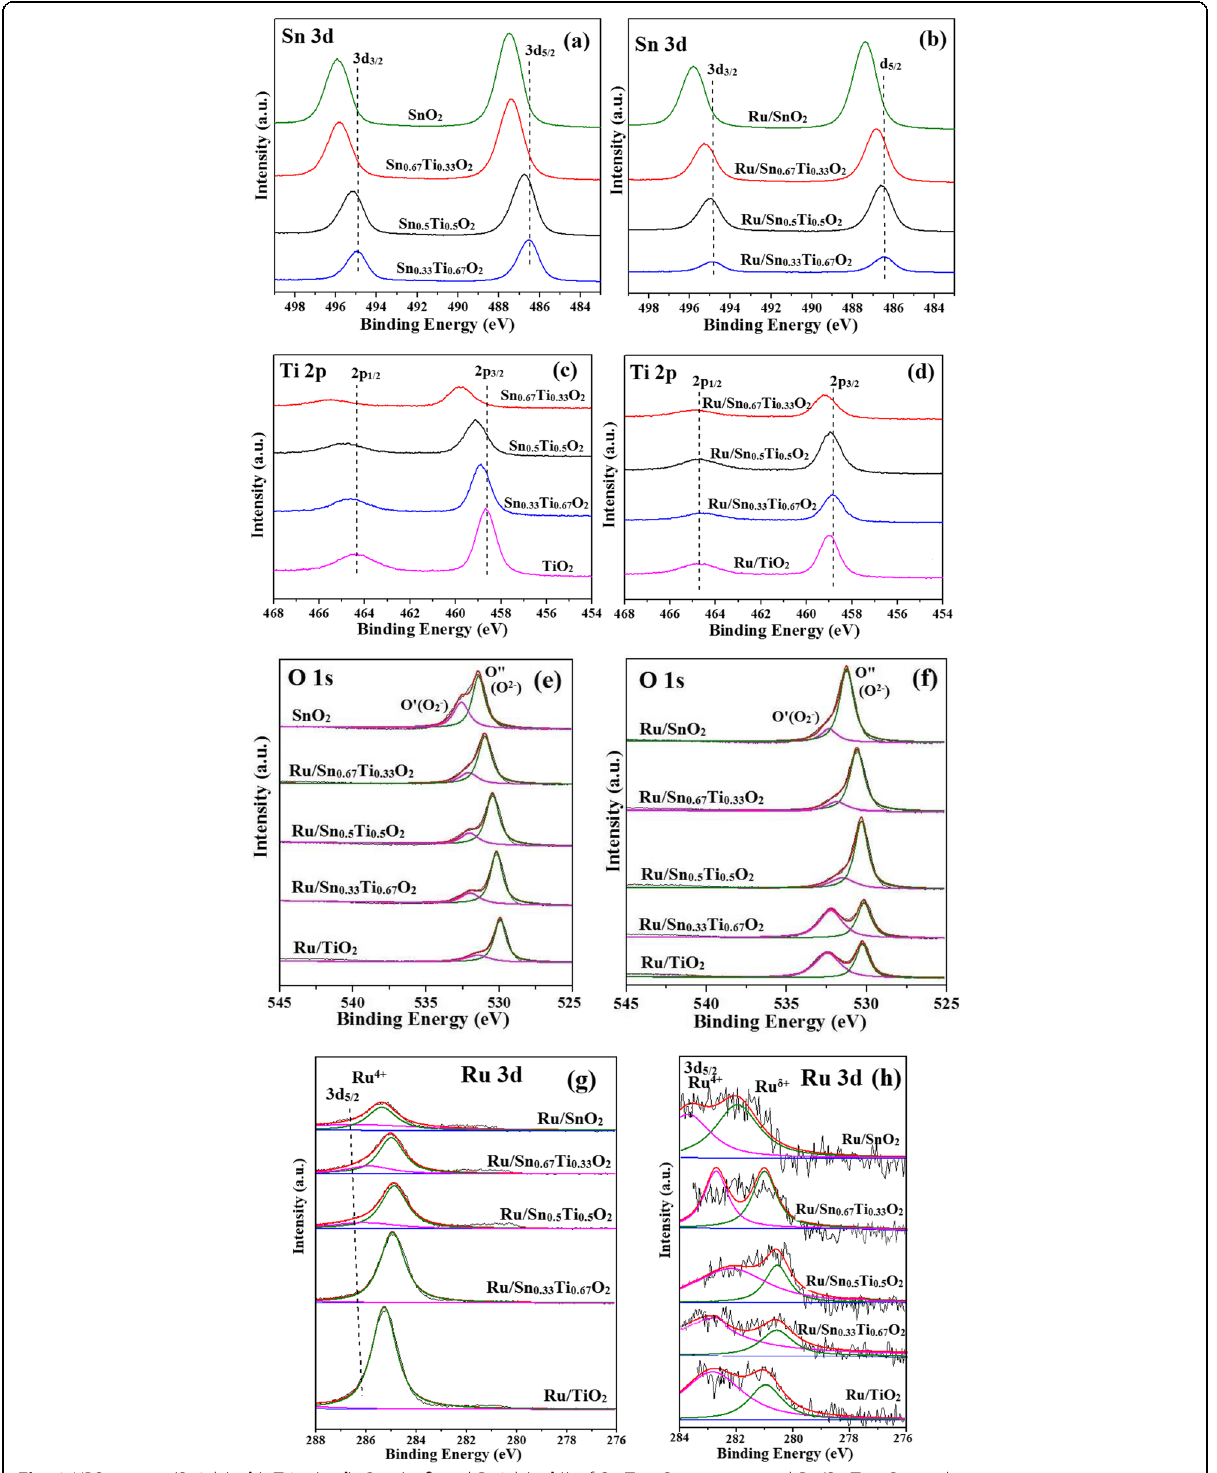
Fig. 8 XPS spectra (Sn3d ( a , b ), Ti2p ( c , d ), O1s ( e , f ) and Ru3d ( g , h )) of Sn x Ti 1 − x O 2 supports and Ru/Sn x Ti 1 − x O 2